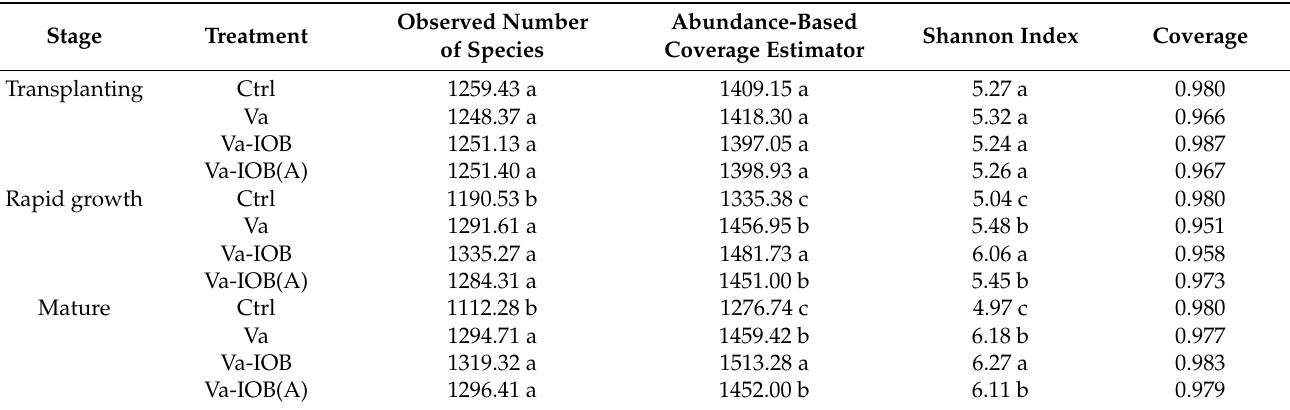
Table 1. α -diversity of sediment bacterial communities evaluated based on operational taxonomic units (OTUs) clustered at the 97% similarity